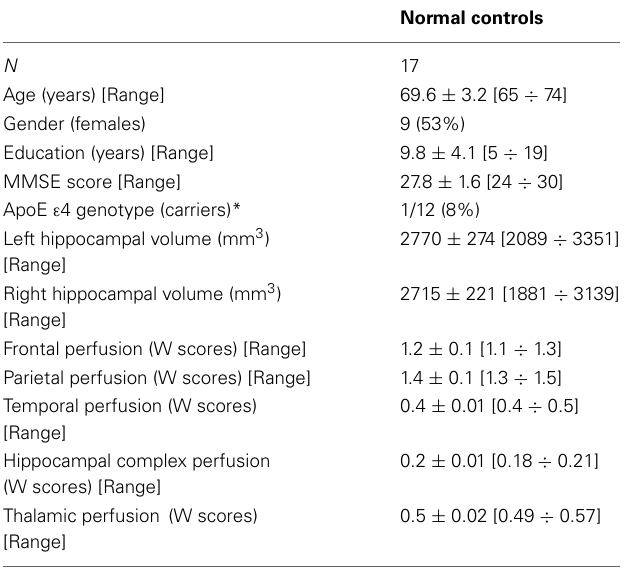
Table 3 | Socio-demographic, clinical volumetric, and brain perfusion features of normal elders enrolled in the study.